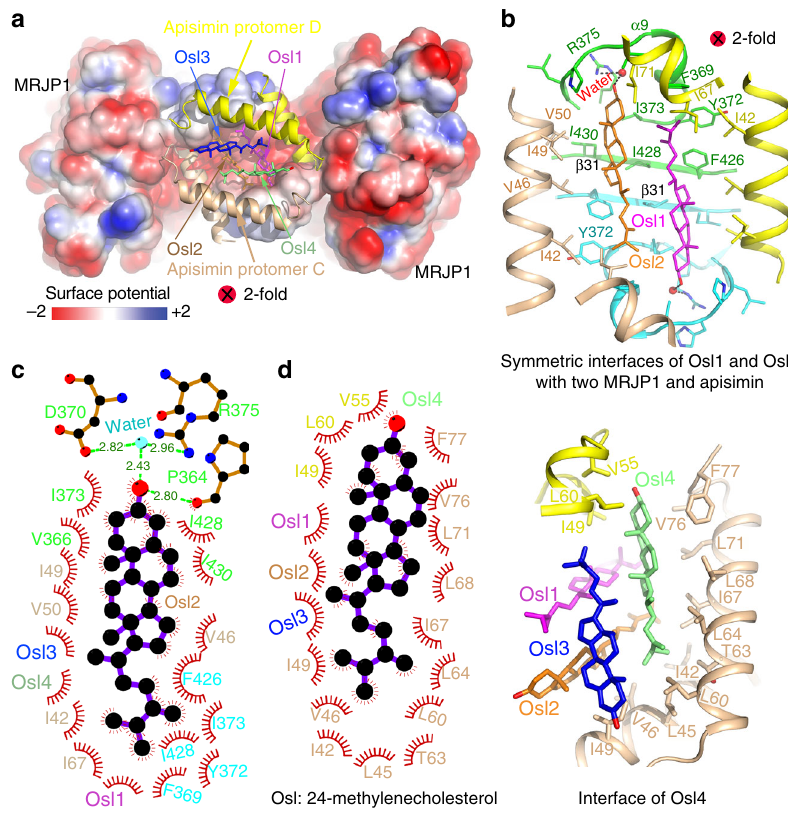
Fig. 5 Detailed interactions of Osl in the MRJP1 oligomer. a Four Osl molecules in the surface potential of MRJP1. b Interactions of the inner two Osl molecules with MRJP1 and apisimin. c Interactions of Osl2 calculated by Ligplot. d Interactions between the outer Osl4 and surrounding residues